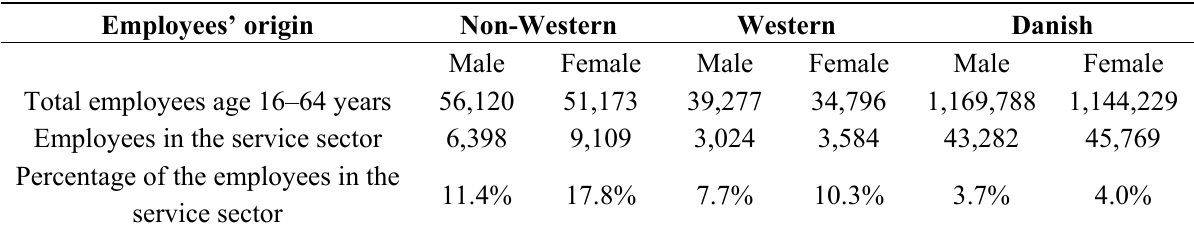
Table 1. Employees in the service sector compared to all employees (ages 16–64 years) at the labour market according to origin and gender, 2009